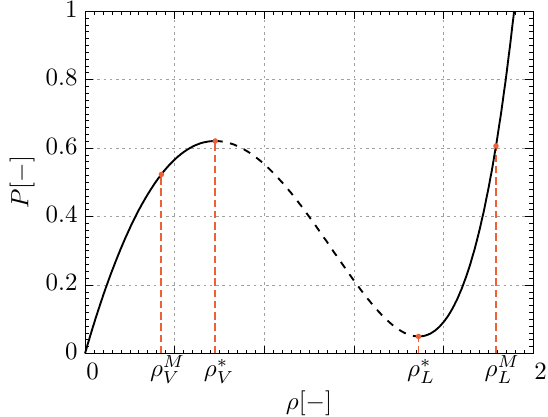
and ρ M are V L and ρ ∗ are local extrema of the V L